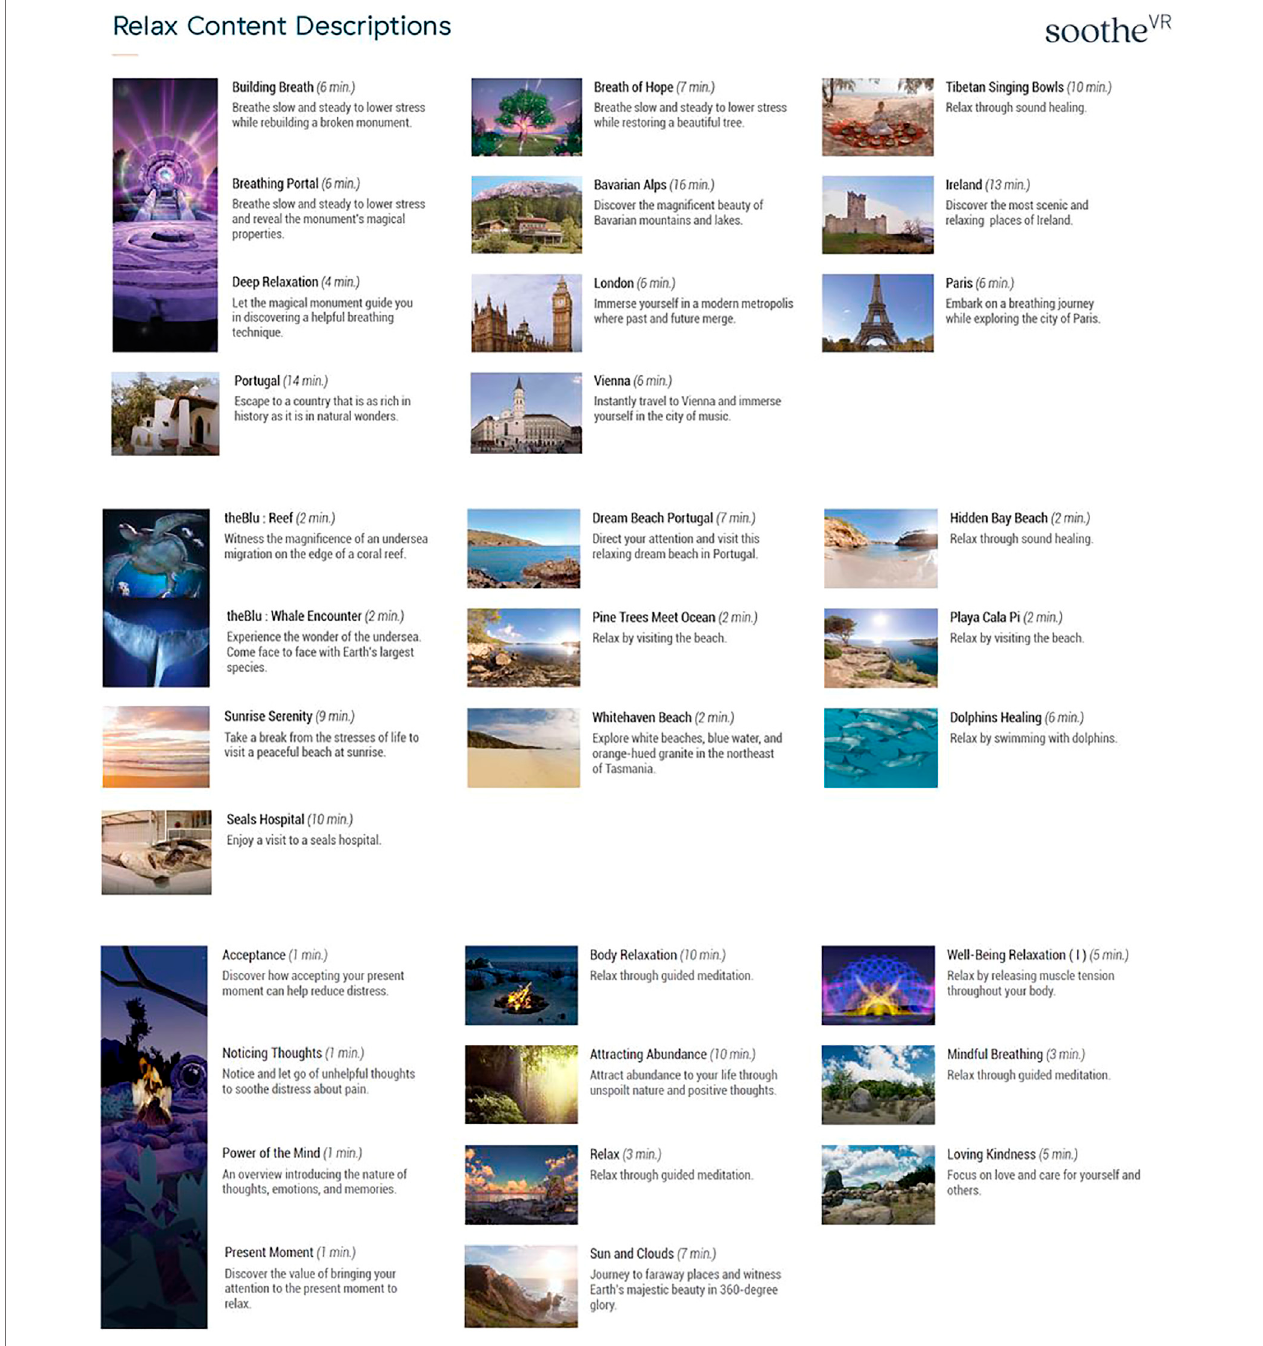
FIGURE 1 | Screenshots, titles, durations, and descriptions of VR experiences available to patients in study. Complete list of content provided, with permission, from AppliedVR (2021).